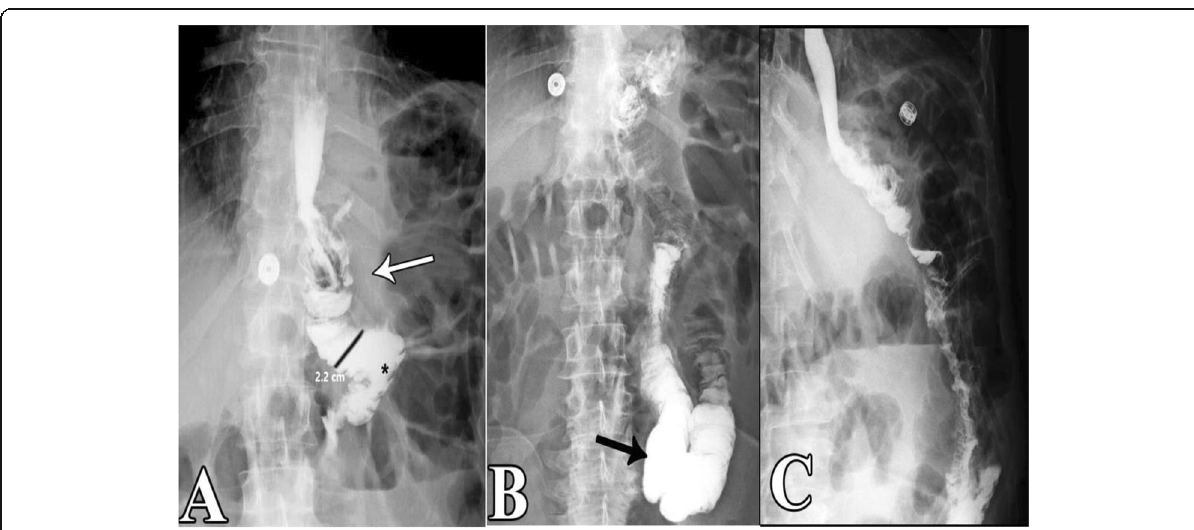
Fig. 5 A 23-year-old female patient underwent a surgical Roux-en-Y gastric bypass since 2 months presented with constipation and abdominal cramps. Diluted water-soluble upper gastrointestinal study: opacified gastric pouch (white arrow), free passage of contrast in the Roux limb (*) with an average diameter of 2.2 cm and normally less than 2.5 cm, and no evidence of stenosis/stricture. Diagnosis: essentially normal findings after RYGB